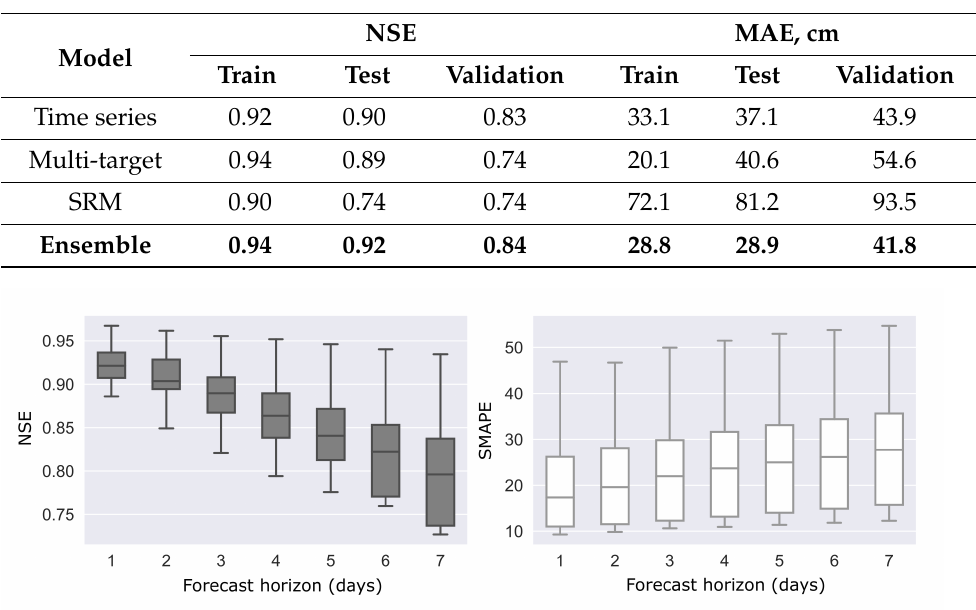
Table 6. The value of the NSE and MAE metrics for stand-alone models and for ensemble.